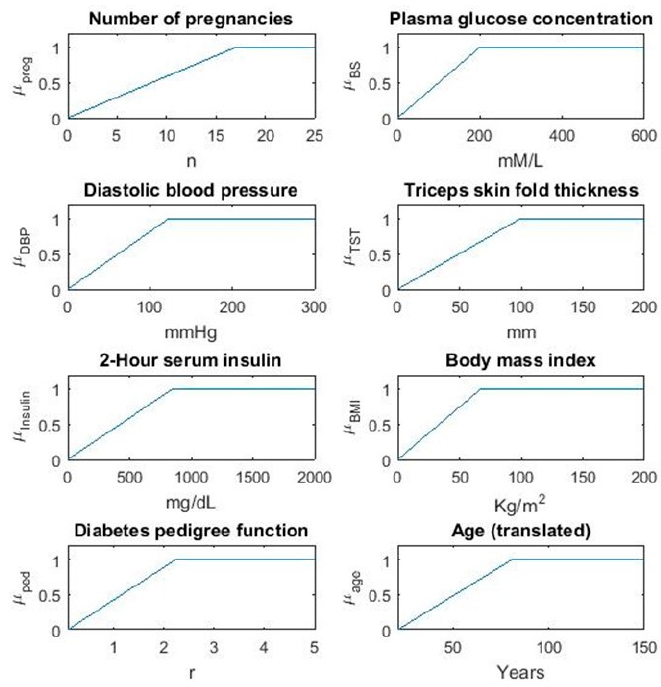
Figure 2. Fuzzy membership values for variables.